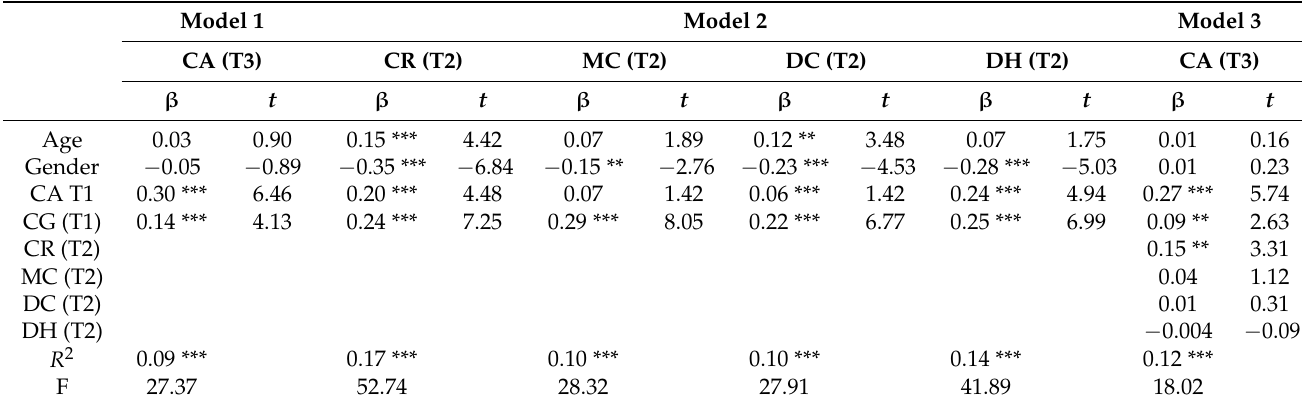
Table 2. Testing the mediation effect of cybergossip T1 on cyberaggression